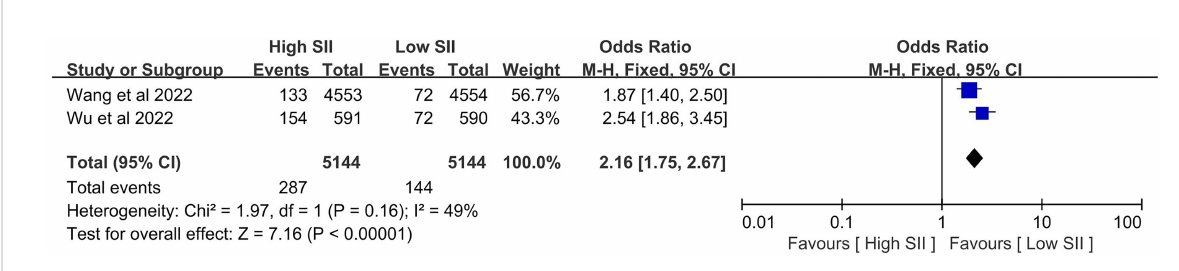
FIGURE 3 The mortality between the high SII and low SII groups.